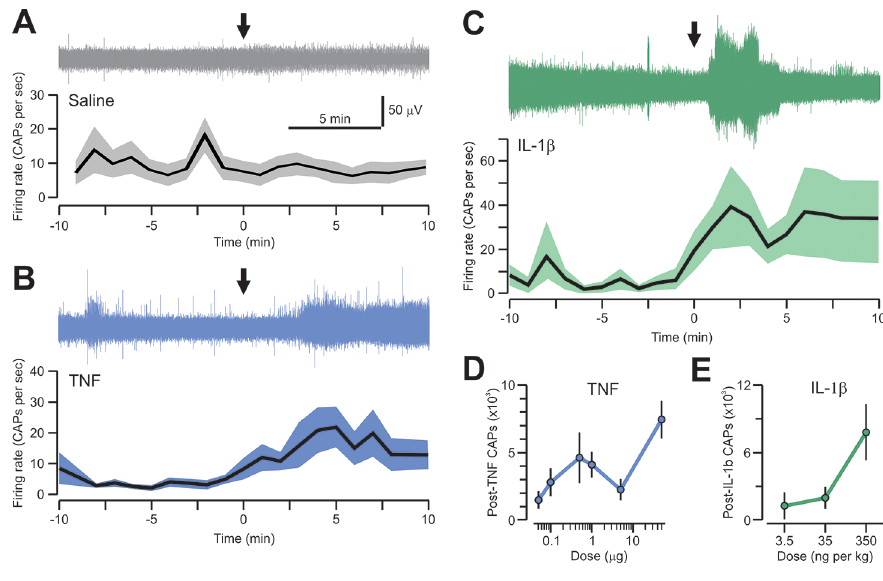
Figure 5. Time course for TNF- and IL-1 β –mediated neurograms. (A) (Top) Trace showing vagus nerve activity under vehicle (200 μ L sterile saline, marked by line), which is used as control. (Bottom) Graph describing the frequency of CAP firing (mean ± SEM, gray area) for N = 6 mice starting 10 min prior to saline injection. (B) (Top) Representative neurogram for TNF (dose of 50 μ g, marked by line). (Bottom) Graph showing the mean frequency ± SEM (blue area) for N = 21 mice. (C) (Top) Representative neurogram for IL-1 β (dose of 350 ng, marked by line). (Bottom) Graph showing mean frequency ± SEM (green area) for N = 10 mice. (D) Plot depicting the total CAP counts (mean ± SEM) in the 10 min immediately after TNF administration at the indicated doses ( N = 5–7 mice per dose). (E) Plot showing total CAP counts in the 5 min following IL-1 β treatment at the indicated doses ( N = 5–9 mice per